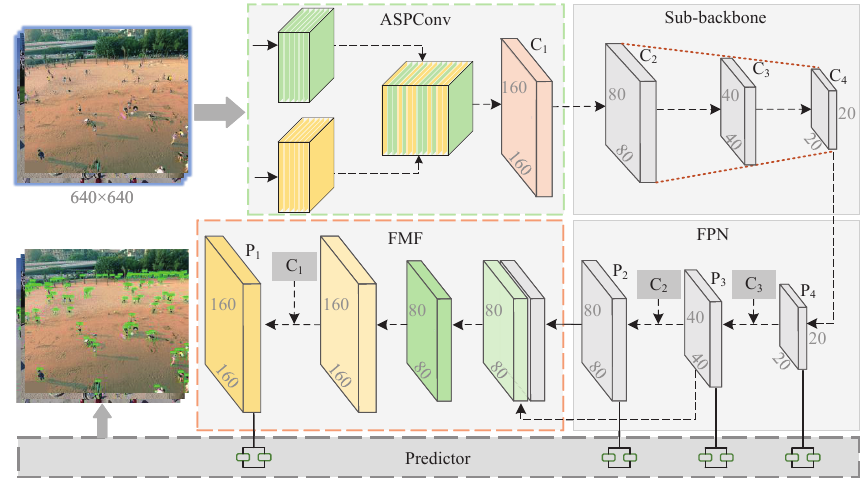
Figure 2. The structure of SODNet. SODNet consists of four components. (1) ASPConv module (shown in Section 3.1) extracts rich spatial information of objects from the input image. (2) The proposed backbone module (shown in Section 3.2) is composed of two components: sub-backbone and FPN. The sub-backbone further extracts the output features of the ASPConv module and generates multi-scale feature maps through FPN. (3) FMF module (shown in Section 3.3) quickly fuses both semantic and spatial information in multi-scale feature maps to generate high-resolution feature maps that are conducive to small object detection. (4) Predictor (shown in Section 3.4) classifies and locates the fused multi-scale feature maps.